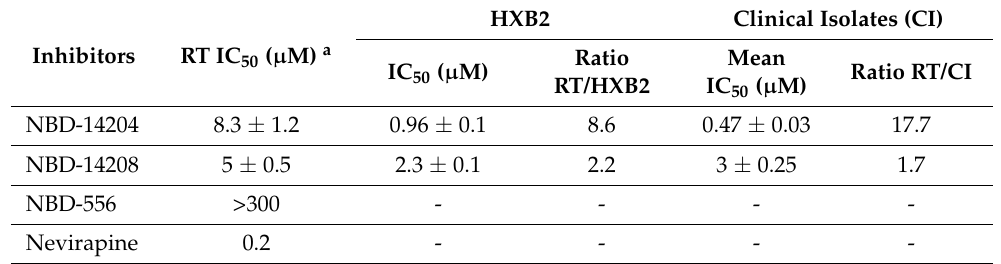
Table 2. Antiviral Activity of NBD Compounds against HIV-1 Reverse Transcriptase, HIV-1 HXB2 and Clinical Isolates (CI) and relative